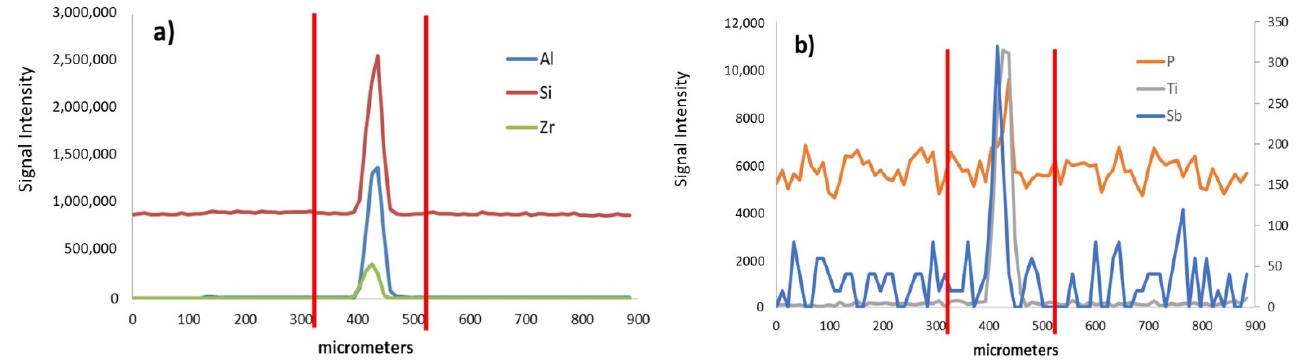
Figure 3. ( a ) Al, Si, and Zr ( b ) P, Ti, and Sb signal intensities versus the length of the first scan line used to ablate the inclusion # 1 present in film # 2. Signals for Sb are shown in the right y-axis.